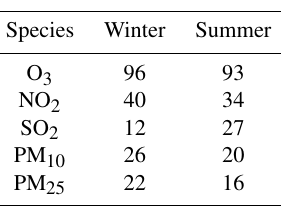
Table 6. Number of EMEP stations per species and per season used for performance statistics. Stations CH01, CH04, CH05, DE03, DE08, AT05, AT48, IT01, IT04, ES78 and DE44 were excluded from the analysis due to their topography difficult to simulate with a 0.5 ◦